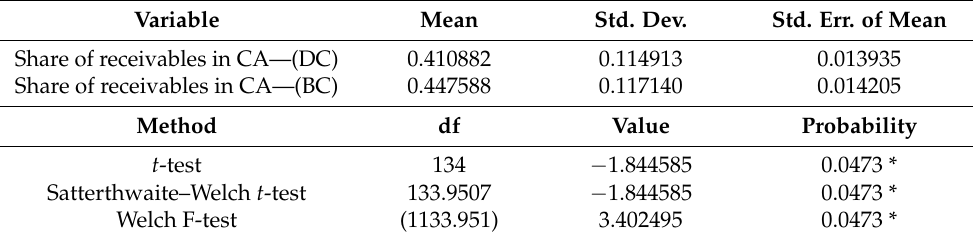
Table 14. The result of the share of receivables in current assets. Variable Mean Std. Dev. Std. Err. of Mean 0.410882